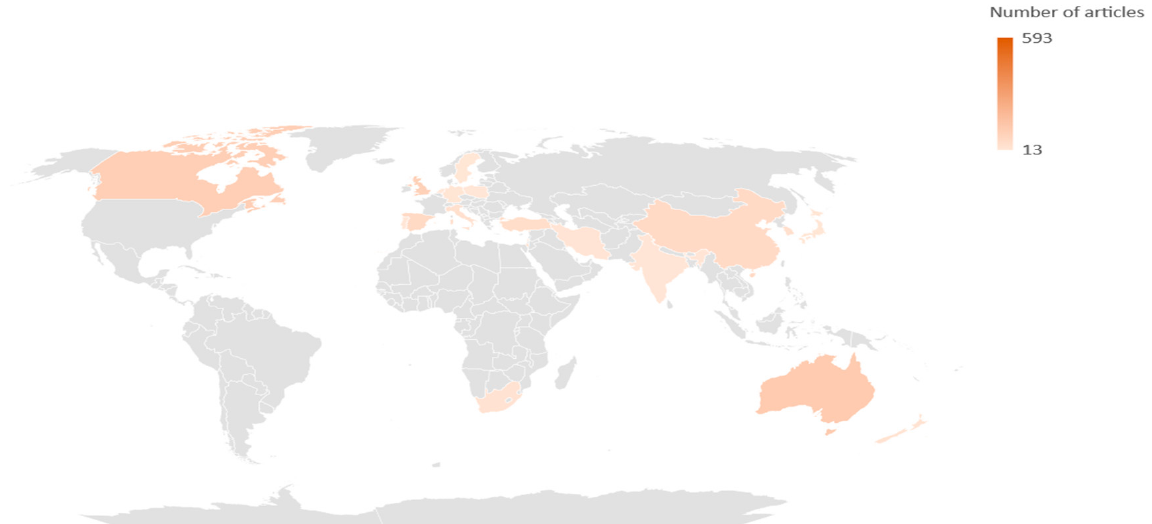
Figure 2. Distribution of articles by country.